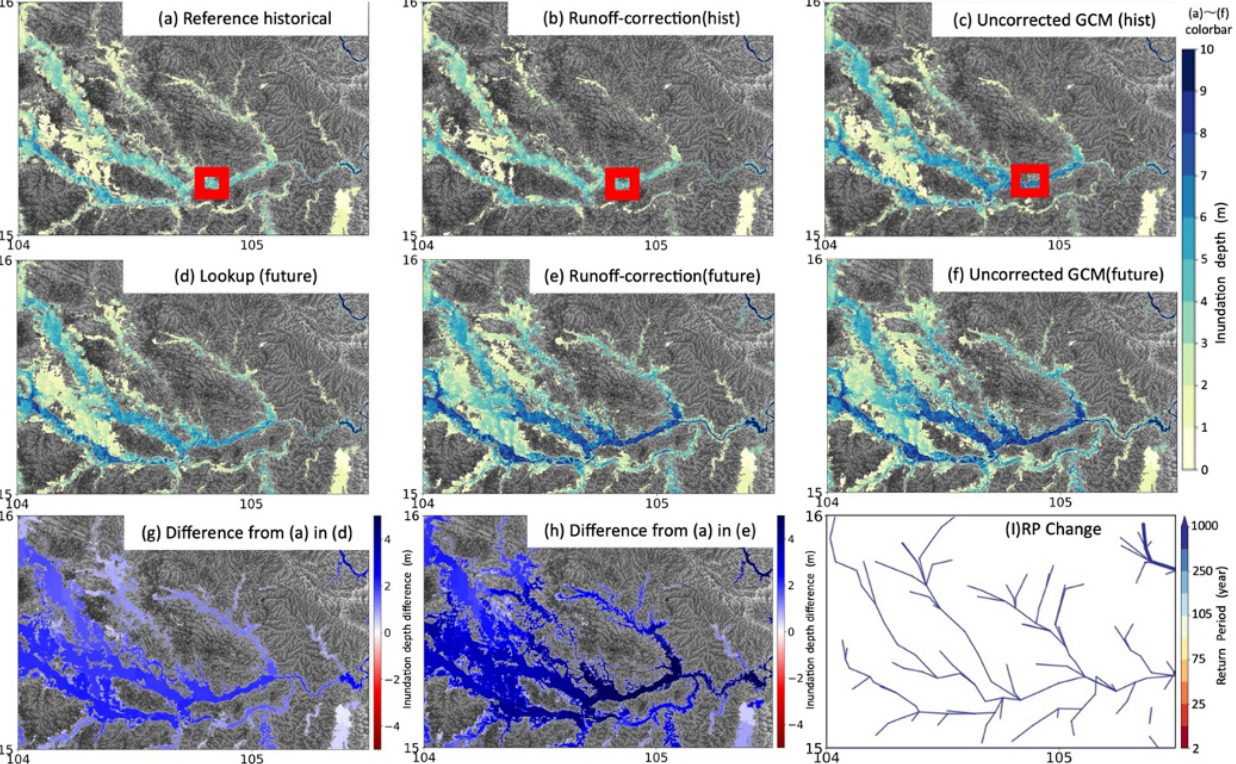
Figure 3. 100-year RP hazard map for the Chi-Mun River basin (using the IPSL-CM6A-LR CMIP6 GCM). (a) Reference historical-hazard map (based on reanalysis data), (b) hazard map constructed using the runoff-correction method (historical), (c) hazard map based on uncor- rected GCM runoff (historical), (d) hazard map constructed using the lookup method, (e) hazard map constructed using the runoff-correction method (future) and (f) hazard map based on uncorrected GCM runoff (future). (g, h) Differences from the reference historical-hazard map in (g) the hazard map obtained with the lookup method and (h) the hazard map obtained using the runoff-correction method (future) and (i) historical RP of river water level corresponding to the 100-year RP in the future. Red boxes in panels (a) – (c) indicate the location of the GRDC Ubon station (104.8617 ◦ E, 15.2217 ◦